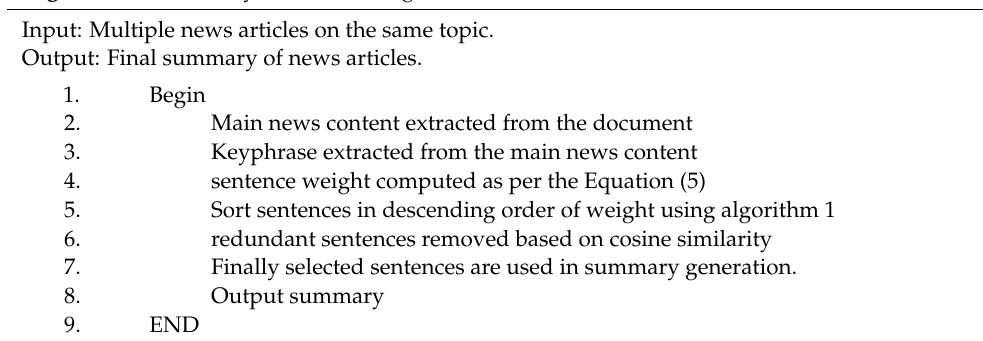
Algorithm 2 : Summary Generation